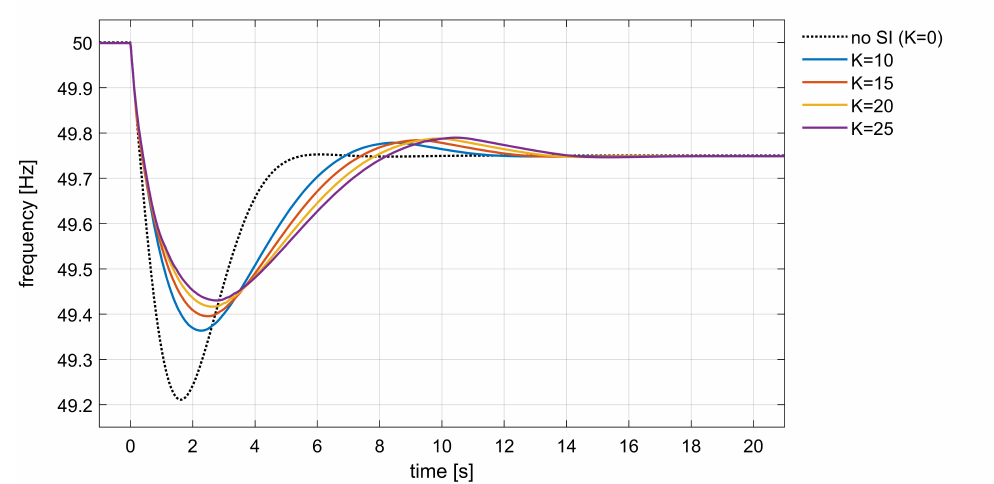
Figure 6. Ideal SI controller: frequency response with different gain K .